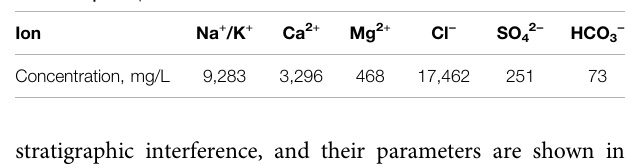
TABLE 2 | Composition of formation